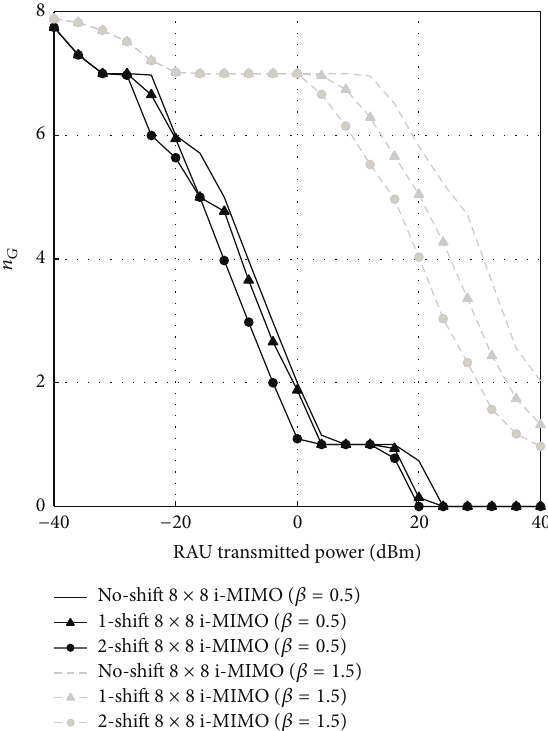
Figure 10: Performance comparison of different 8-branch i-MIMO 2D deployments (no-shift, 1-shift, and 2-shift). Average number of branches under threshold ( 𝑛 𝐺 ) is shown, for different values of the propagation model parameters (RAU antenna distance: 20